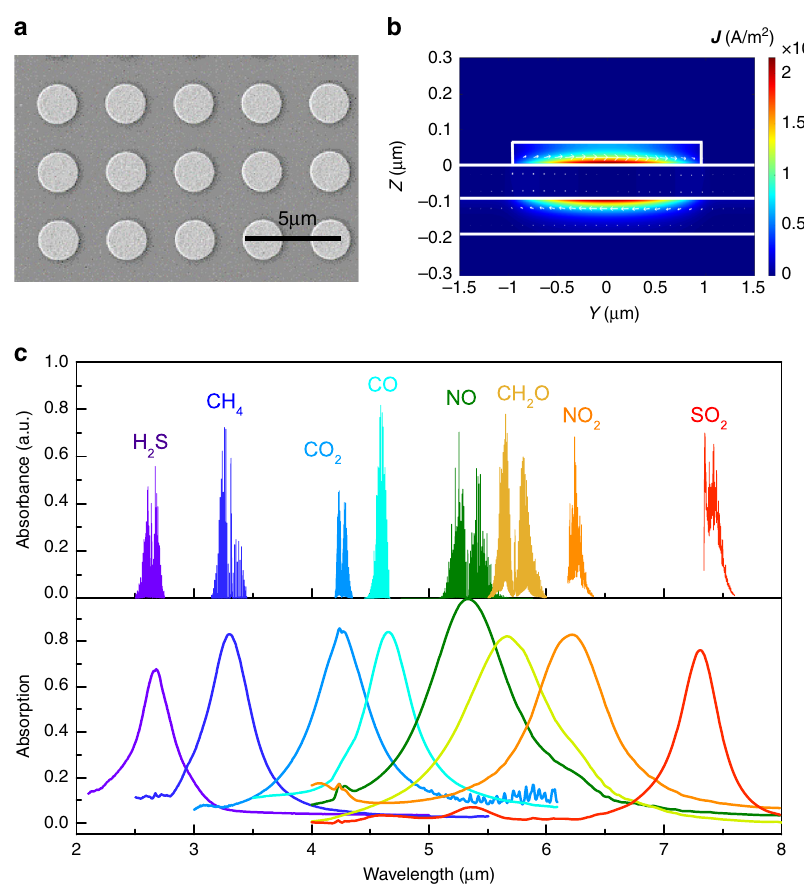
Fig. 2 The spectral and near- fi eld properties of the plasmonic metamaterial absorbers. a The scanning electron microscope (SEM) image of the gold nanodisk antenna array. b The distribution of light-induced current density magnitude | J | and current density vector J in the YZ cut-plane of the MIM absorber at λ peak = 5.73 μ m, obtained by COMSOL, a fi nite element method-based solver. c The measured absorption spectra of 8 fabricated MIM absorbers compared to the infrared absorption bands of eight target gases: H 2 S, CH 4 , CO 2 , CO, NO, CH 2 O, NO 2 , SO 2 . See Supplementary Note 7 for the absorption spectra in the full wavelength range. Source data are provided as a Source Data fi